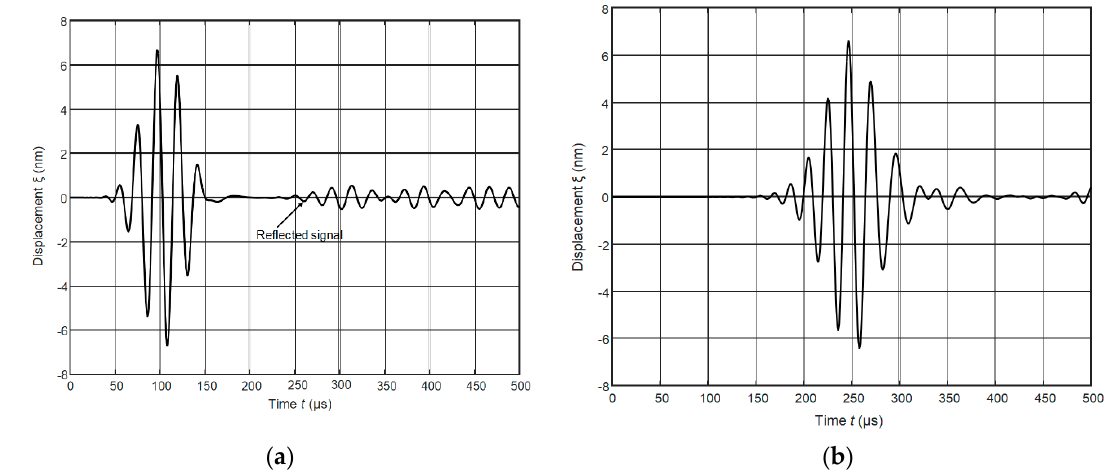
Figure 5. Ultrasonic pulses at two different distances from the 1 × 5 mm 2 excitation zone: ( a ) 10 mm; ( b ) 40 mm.